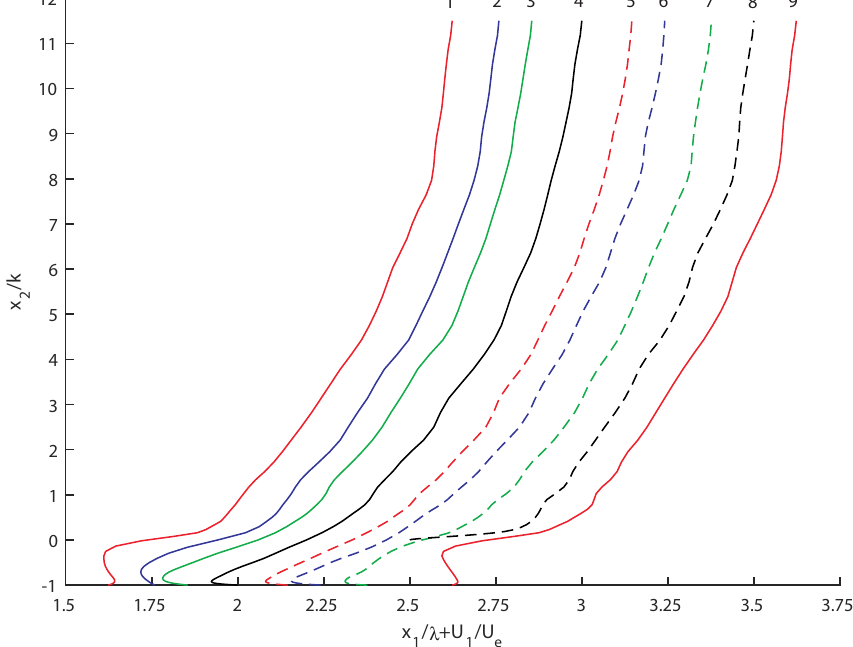
Figure 15. Vertical profiles (1, 2, ..., 9) of predicted mean-velocities U 1 for Run 3 at 9 locations within a pitch ( λ ) from the 2nd bar (downstream face) to the 3rd bar (downstream face). The longitudinal coordinates are x 1 / λ equal to 1.623, 1.759, 1.855, 2.0, 2.145, 2.241, 2.377, 2.5, and 2.623, respectively. The average of the velocities at the water surface is taken as the freestream velocity. The locations are in the channel center